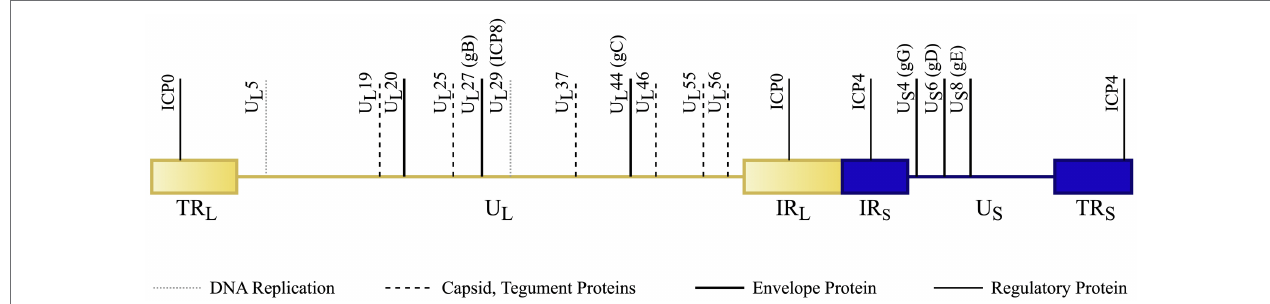
FIGURE 2 | HSV genome schematic (not to scale) with notable vaccine targets. The dsDNA genome is divided into the U L (unique long sequence – light, shaded yellow) and U S (unique short – dark blue). Short regions of repeated sections occur at the ends of each of these sequences. Terminal repeats (TR L and TR S ) occur at the ends of the genome and internal repeats (IR L and IR S ) flank the transition between the long and short segments. Vaccines are developed with broad targets involving envelope, capsid, tegument, DNA replication, and regulatory proteins. The genes coding for these protein targets are specifically denoted in the above image. Original Image. References: (Dolan et al., 1998; Lim et al., 2013; Jiao et al., 2019; Denes et al.,